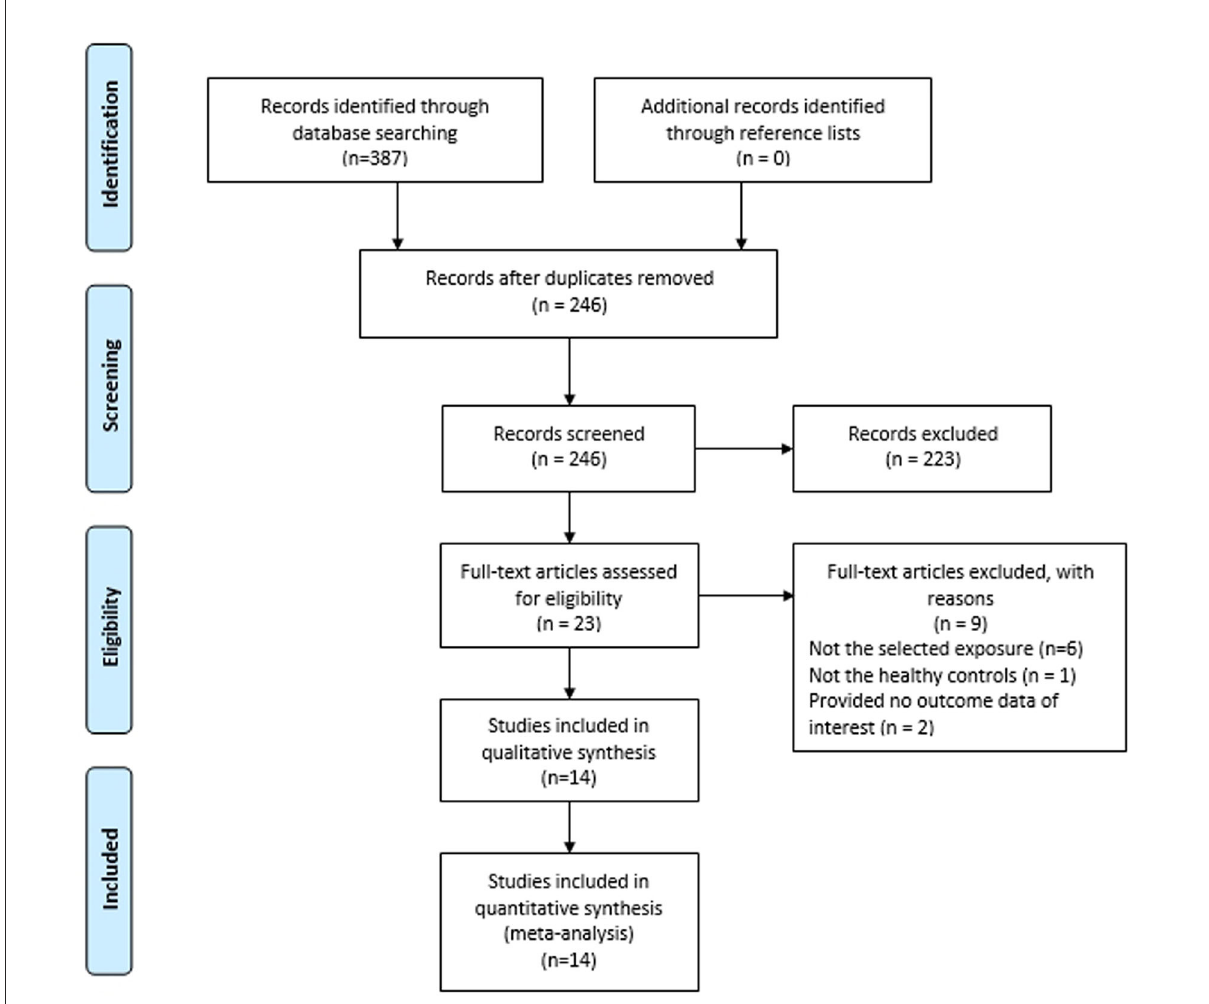
FIGURE1 Flow diagram for identification of eligible studies for this